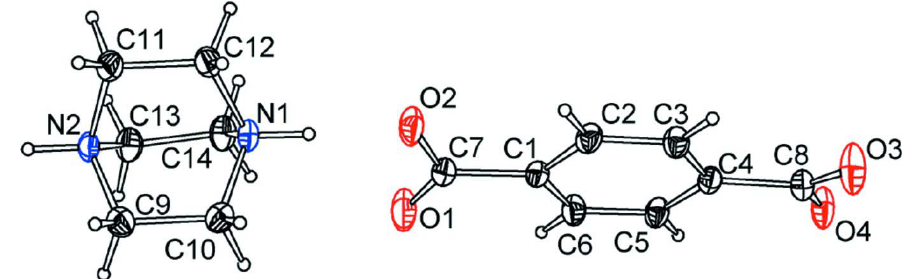
A view of the title compound, showing 30% probability displacement